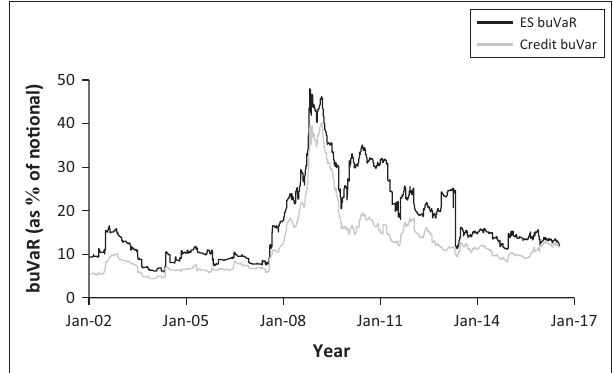
FIGURE 5: Credit bubble value at risk using value at risk and expected shortfall. = 1.0, λ = 0.95). 2 EWMA